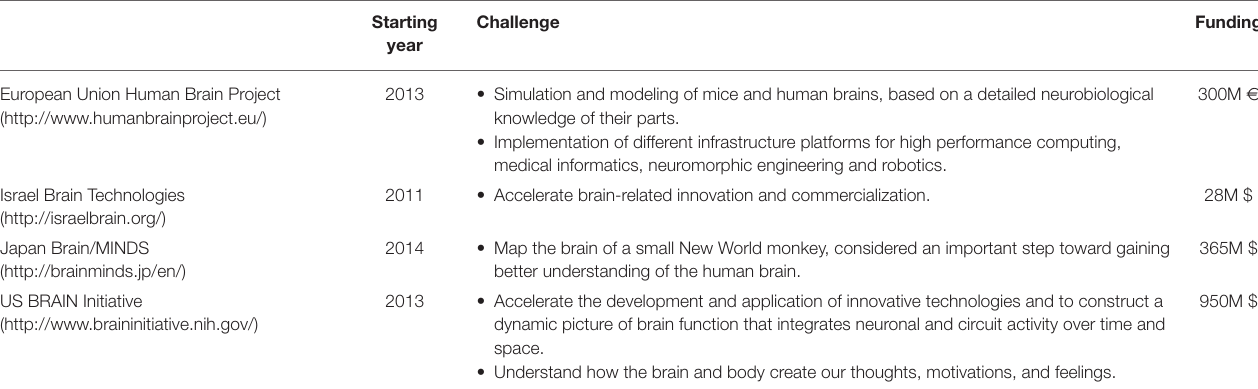
TABLE 1 | Principal global initiatives aimed at studying the brain.